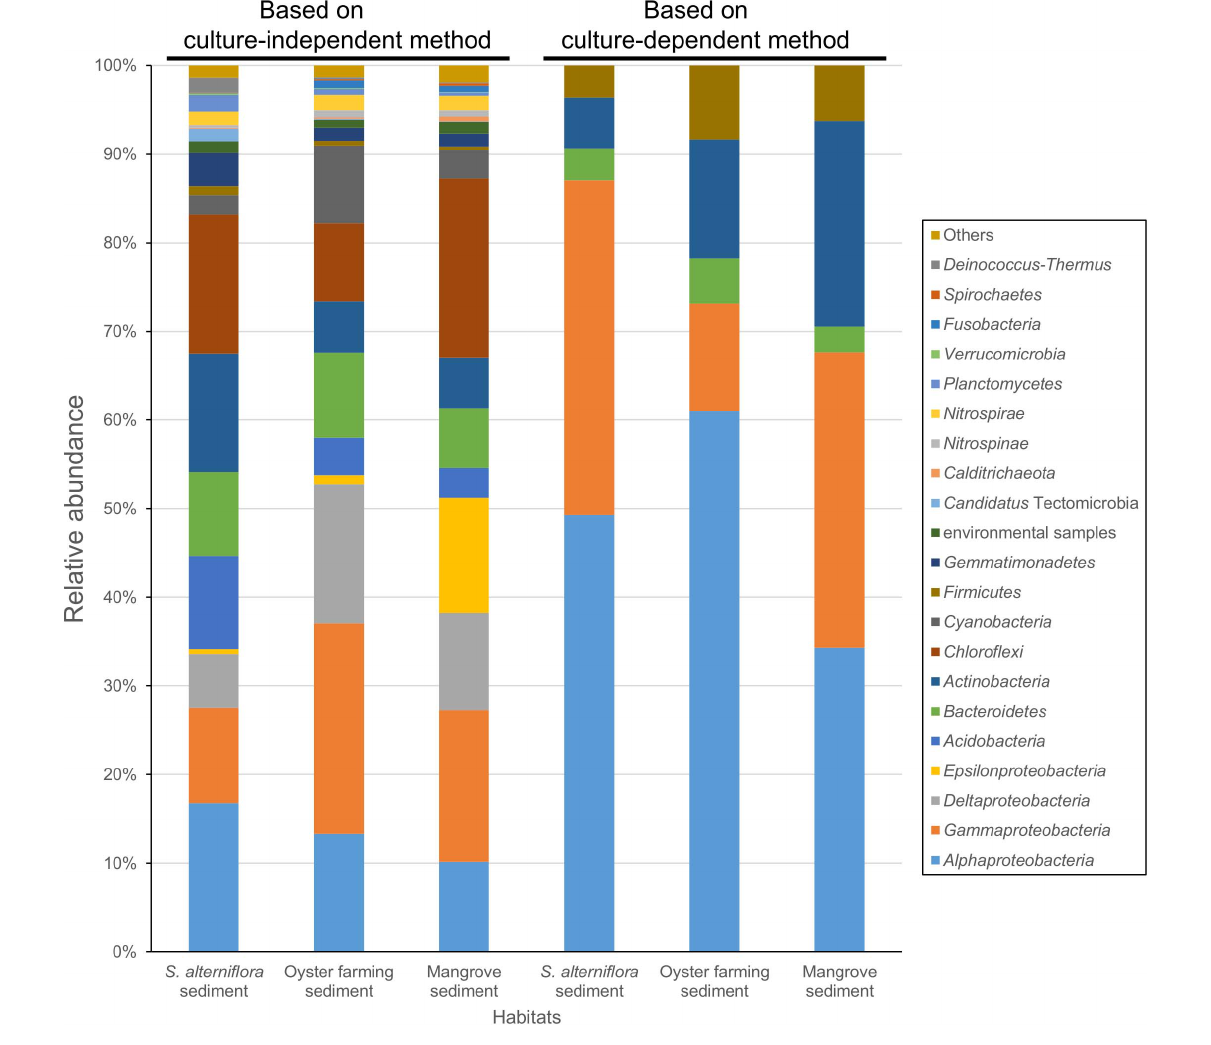
FIGURE 4 | Bacterial groups for the coastal sediments of the three habitats determined by using 16S rRNA gene amplicon sequencing (left three columns) and by cultivation (right three columns). The phylum Proteobacteria is shown at the class level, that is Alphaproteobacteria, Gammaproteobacteria, Deltaproteobacteria, and Epsilonproteobacteria. The taxonomy of ASVs from each sample was assigned based on the lowest common ancestor (LCA)